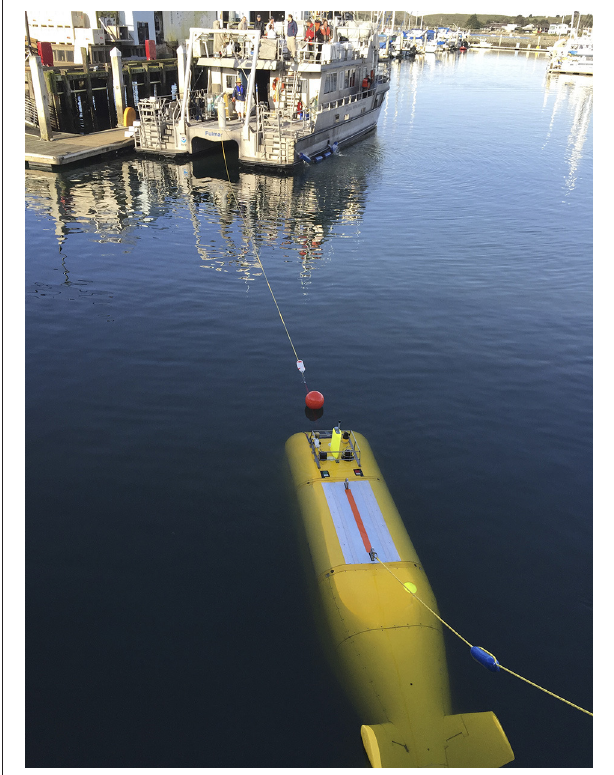
FIGURE 8 | The NOAA vessel Fulmar towing Echo Ranger out of harbor to commence survey operations. (NOAA/Robert Schwemmer).